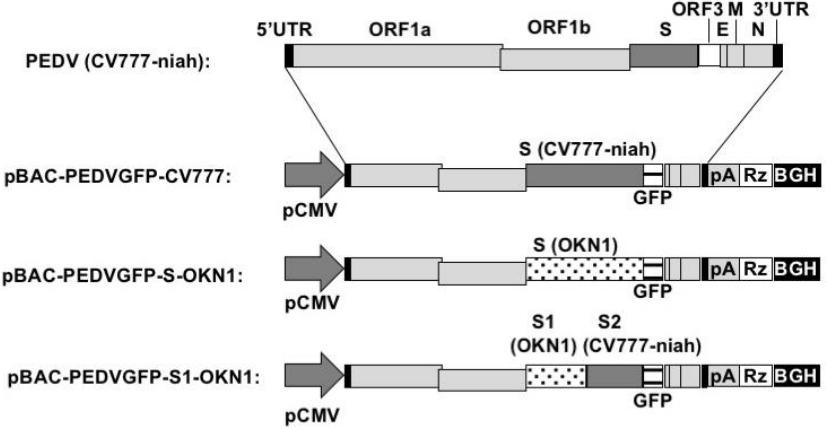
Figure 1. Structure of the PEDV genome from CV777 maintained in National Institute of Animal Health (top) and bacterial artificial chromosome cDNA (2nd, 3rd, and bottom). Black boxes represent 5’ and 3’ untranslated regions. Light gray boxes represent ORF 1a, ORF1b, E, M, and N, while dark gray and white boxes represent S and ORF3, respectively. pCMV, represents cytomegalovirus promoter; pA, polyA tail; Rz, HDV ribozyme; BGH, BGH termination and polyadenylation sequence.